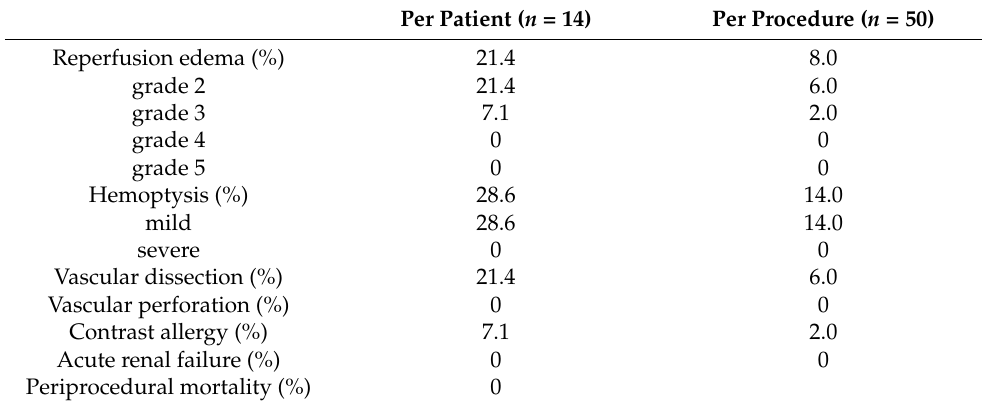
Table 4. Procedural